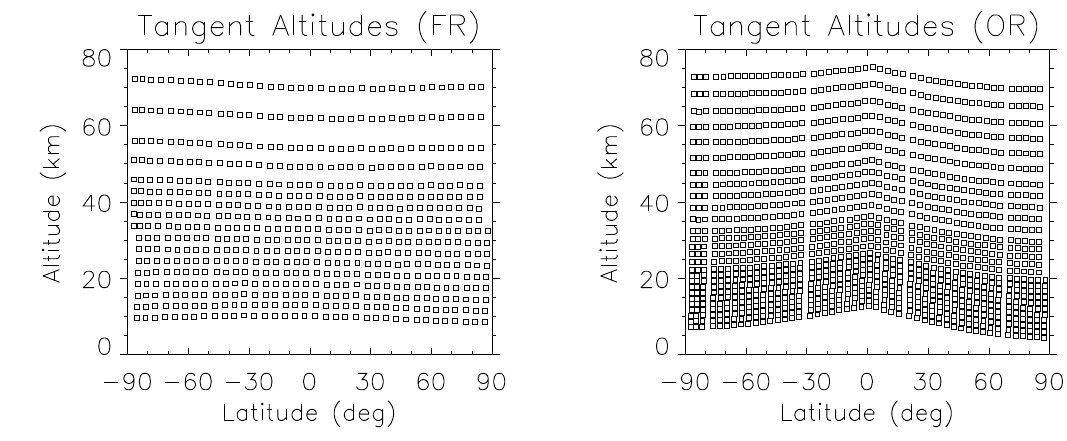
Fig. 1. Left: Tangent altitudes of the FR nominal mode vs. latitude. Right: the same but for the OR nominal mode. (which lasted until March 2004) were taken in the nominal observation mode, with one orbit consisting of 72 limb-scans looking backward along the orbit